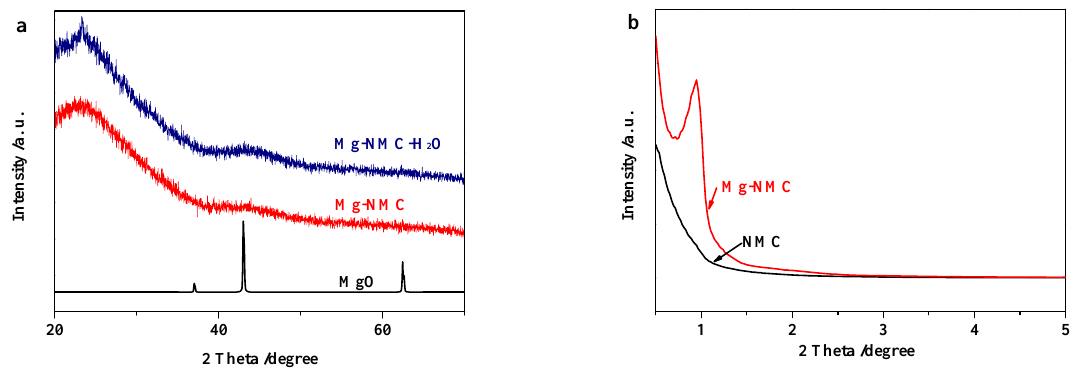
Figure 4. ( a ) Wide-angle XRD patterns of MgO, Mg-NMC and Mg-NMC-H 2 O; ( b ) Small-angle XRD patterns of NMC and Mg-NMC.